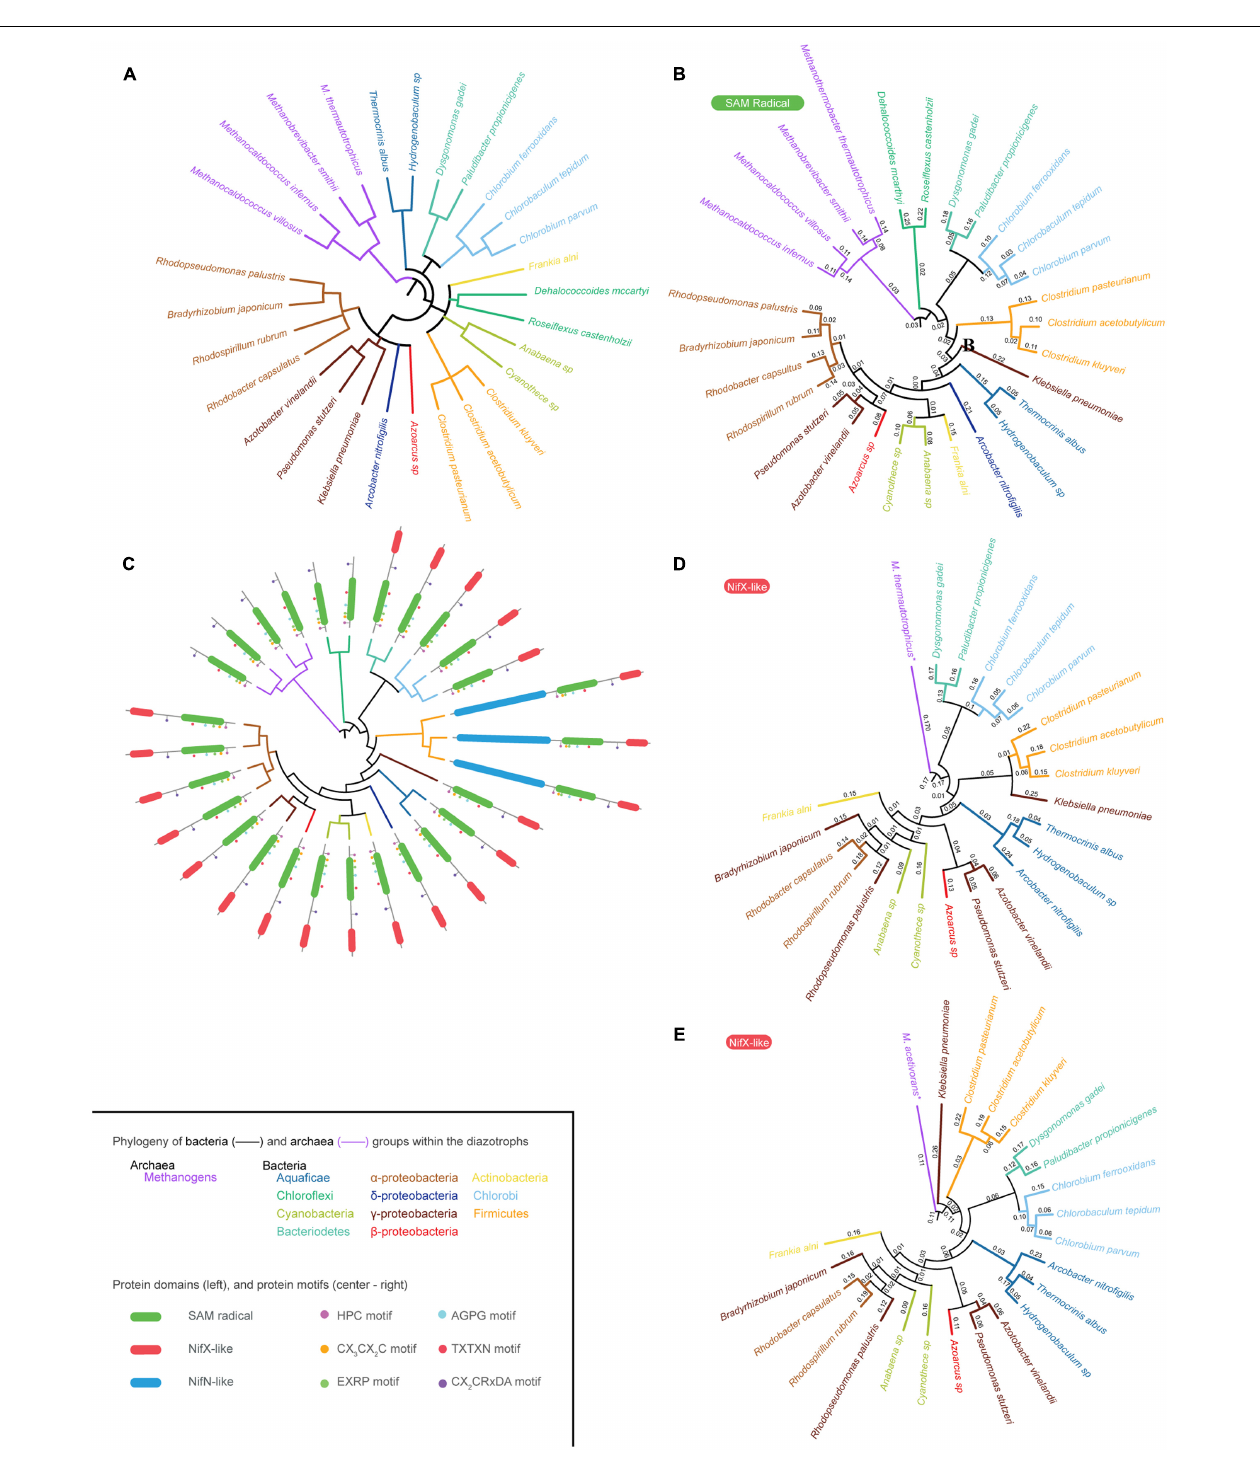
FIGURE 2 | NifB phylogeny. (A) Phylogenetic tree of twenty-eight selected species representing all Bacteria and Archaea groups reported to carry nif genes. (B) Phylogenetic tree of twenty-eight NifB proteins based on their SAM-radical domain. (C) Overlap of the phylogenetic tree shown in (B) and existing NifB architectures. (D) Phylogenetic tree of twenty-two NifB proteins based on their NifX-like domain generated using M. thermautotrophicus NifX as root. (E) Phylogenetic tree of twenty-two NifB proteins based on their NifX-like domain generated using M. acetivorans NifX as root. The inset provides color code for the different Archaea and Bacteria groups with diazotroph members shown in the phylogenetic trees. It also details NifB protein domains and the strictly conserved motifs within the SAM-radical domain (C) .